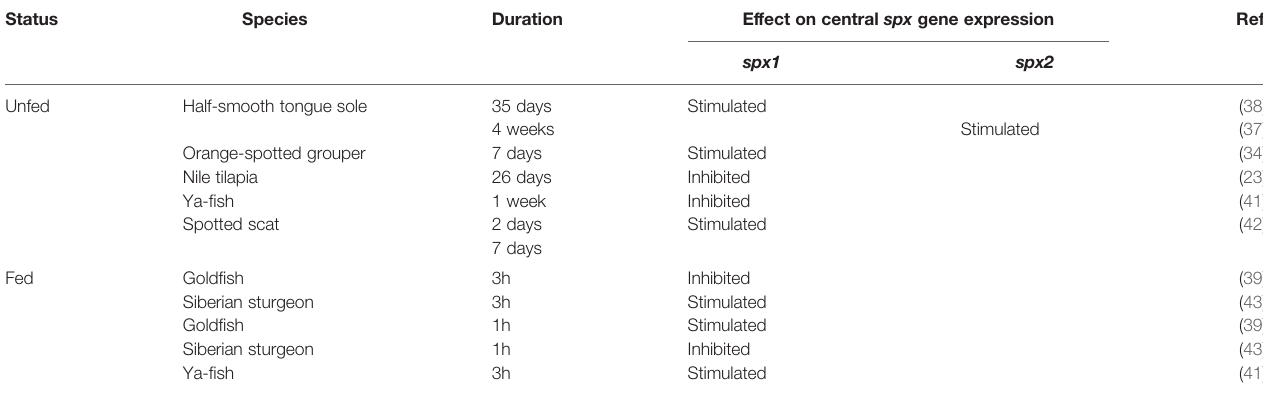
TABLE 4 | Summarised table of effects of metabolic status on central spx gene